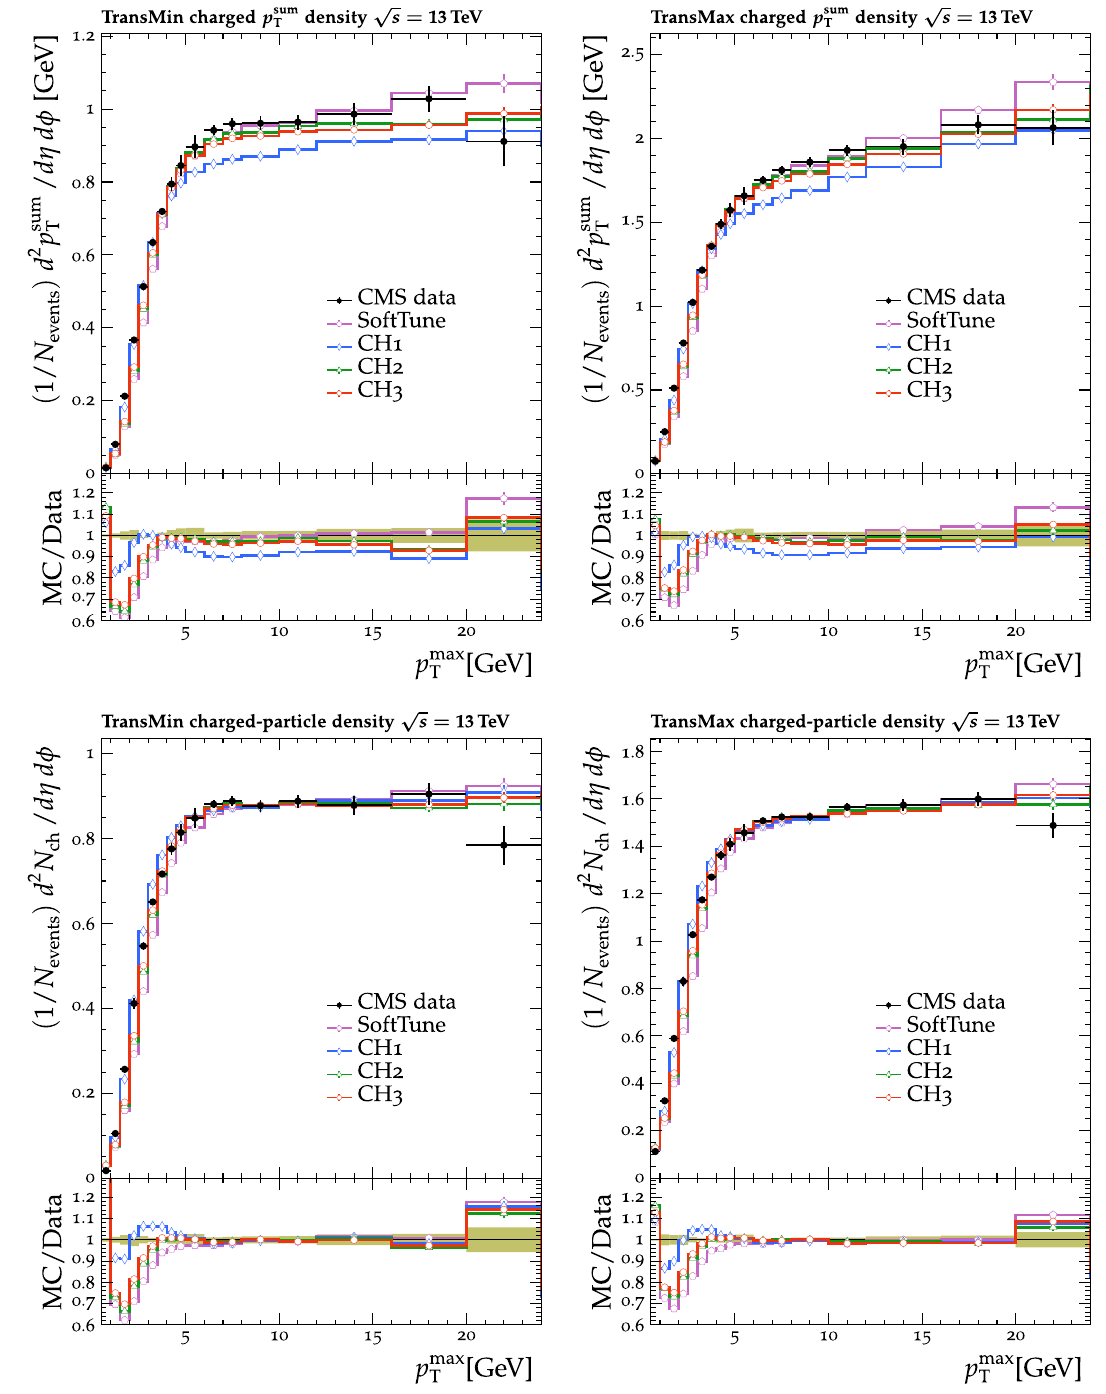
Fig. 3 The normalized p sum (upper) and N ch (lower) density distribu- The coloured band in the ratio plot represents the total experimental T tions in the transMin (left) and transMax (right) regions, as a function uncertainty in the data. The vertical bars on the points for the different of the p T of the leading track, p max [24]. CMS MB data are compared predictions represent the statistical uncertainties T with the predictions from herwig 7, with the SoftTune and CH tunes.